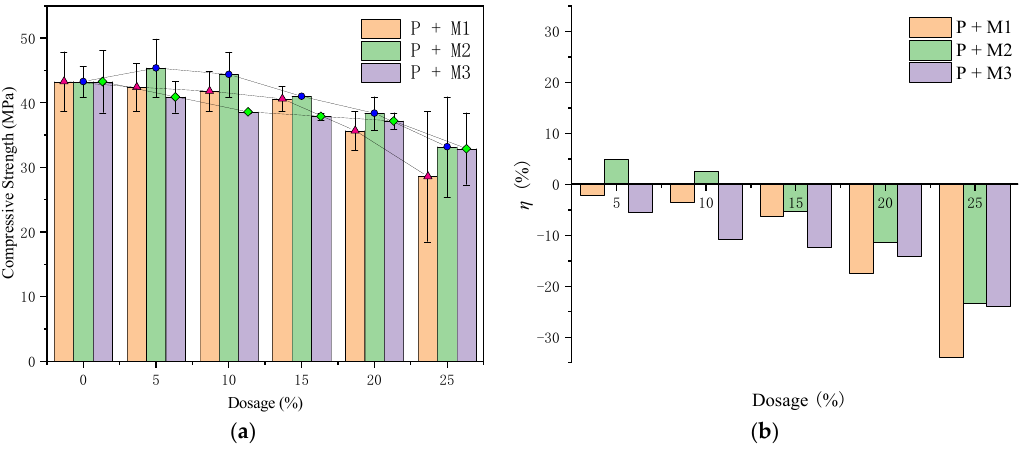
Figure 6. Results of 28 d of compressive strength. ( a ) Compressive strength. ( b ) Efficiency of action.